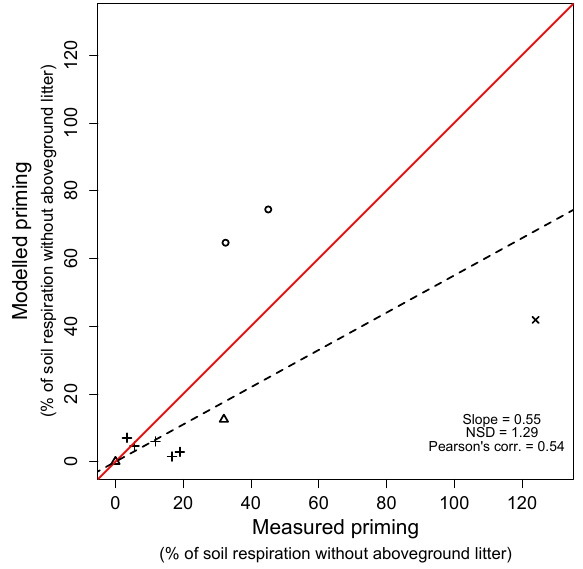
Figure 5. Scatter plot between the priming effect measured and the priming effect calculated by ORCHIDEE–PRIM. Red line indicates the 1:1 line and different symbols indicate different